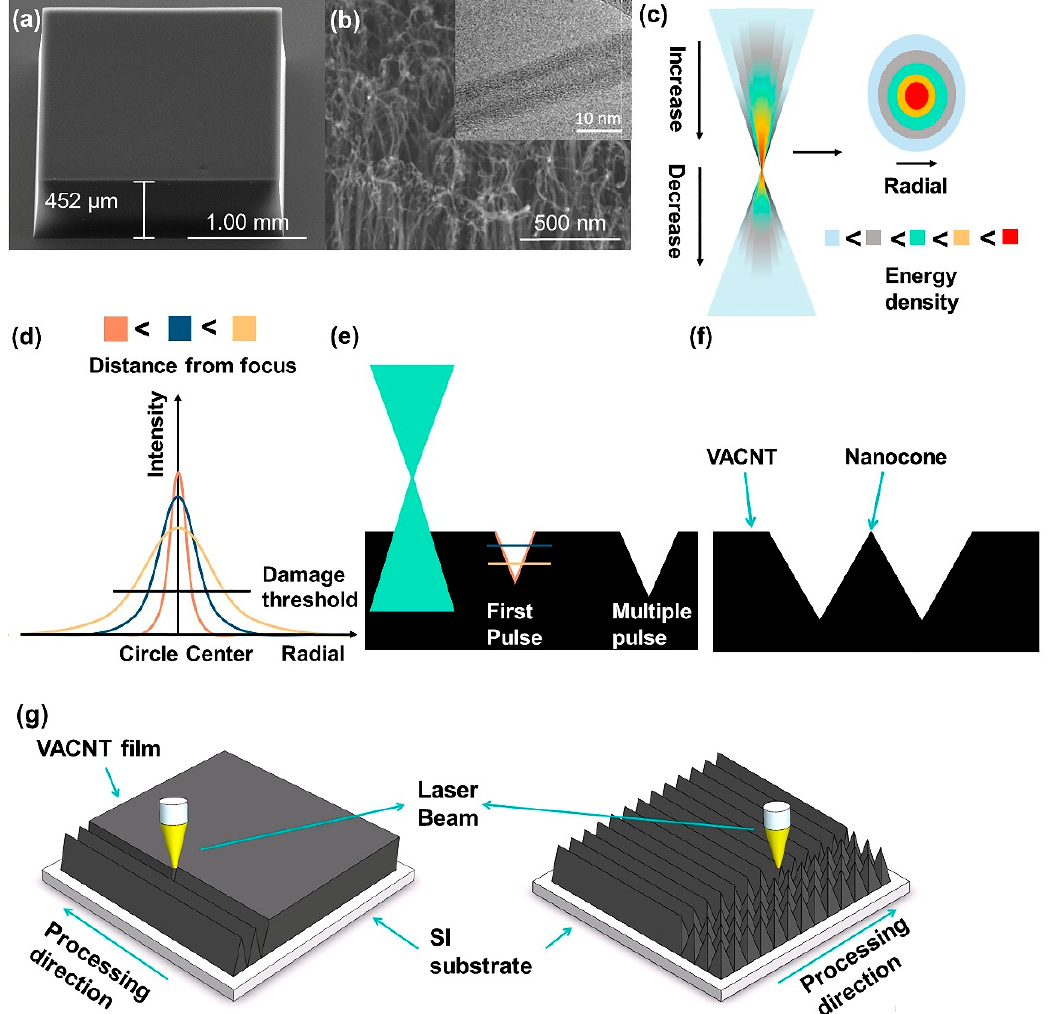
Figure 1. Schematic of the VACNT UV laser patterning process: ( a ) SEM images of a typical as-synthesized PECVD VACNT thin film (scale bar: 1 mm, Tilt: 45°). ( b ) High-resolution SEM image of the VACNT thin film upper surface highlighting the surface disorder and residual catalyst particles (scale bar: 500 nm, Tilt: 45°). Inset: High-resolution TEM of an individual as-grown PECVD CNT showing a wall thickness of approximately 0.12 nm, consisting of three graphitic side walls (scale bar: 10 nm). ( c ) Energy distribution diagram of the laser beam. ( d ) Gaussian distribution of laser beam energy. ( e ) The process of laser beam energy acting on VACNT to form its shape. ( f ) Nanocone and ( g ) Nanocone array formation process.